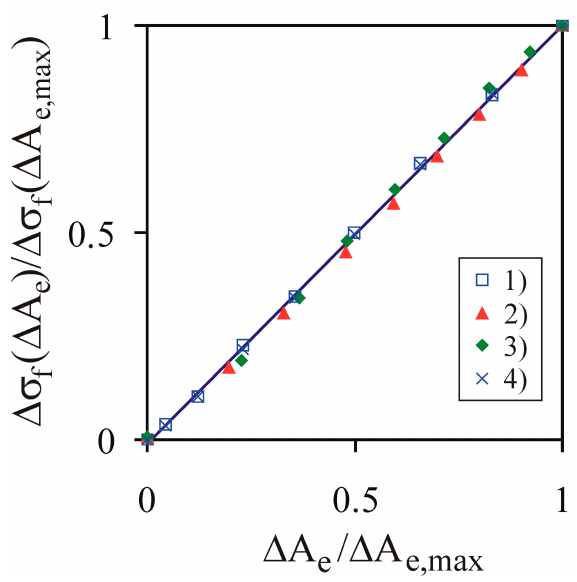
( ∆ A ) / ∆ σ ( ∆ A ) vs. changeofthenormalized e e ,max AA ΔΔΔΔ σσ vs. change of the f f max, efef / AA ΔΔ . max, ee